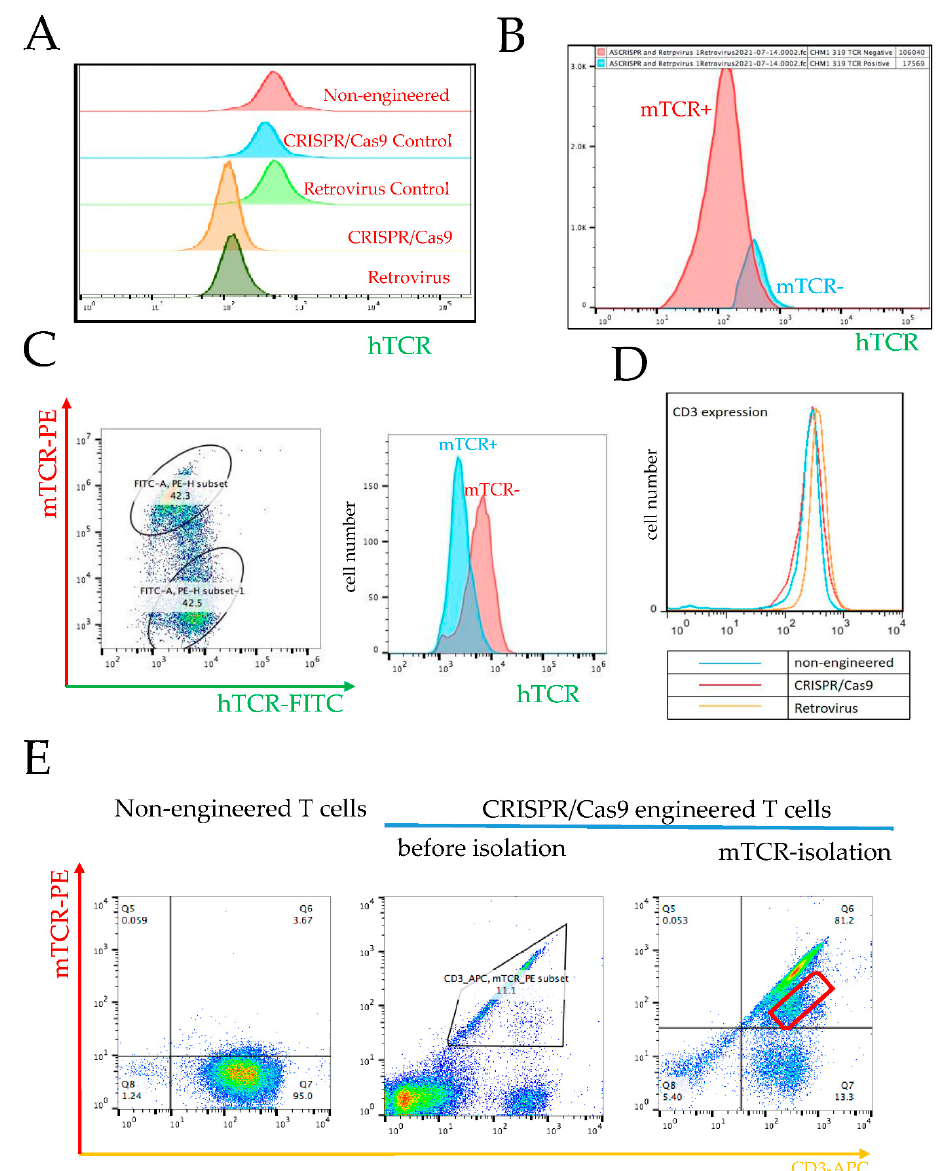
Figure 4. Endogenous TCR expression after gene editing by CRISPR/Cas9 vs. retroviral transduction. ( A ) FACS analysis of expression of endogenous TCR expression (hTCR) from a representative donor: “Non-engineered” designates a control non-engineered T cells; “CRISPR/Cas9 Control” des- ignates a control containing T cells transduced by electroporation of CRISPR/Cas9 but without guide RNA; “Retrovirus Control” designates a control containing T cells exposed to centrifugation only with no retrovirus added; “CRISPR/Cas9” designates T cells with TCR replacement by CRISPR/Cas9, and “Retrovirus” designates T cells with TCR transfer by retrovirus. The “CRISPR/Cas9” and “Retrovirus” groups were analyzed after isolation with anti-mTCR antibody.